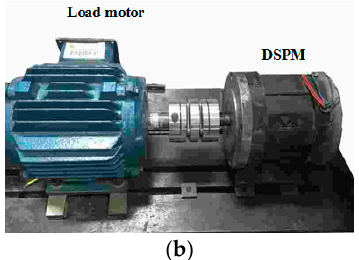
Figure 8. Photograph of experimental test-bed. ( a ) Control circuit; ( b ) DSPM and load motor.